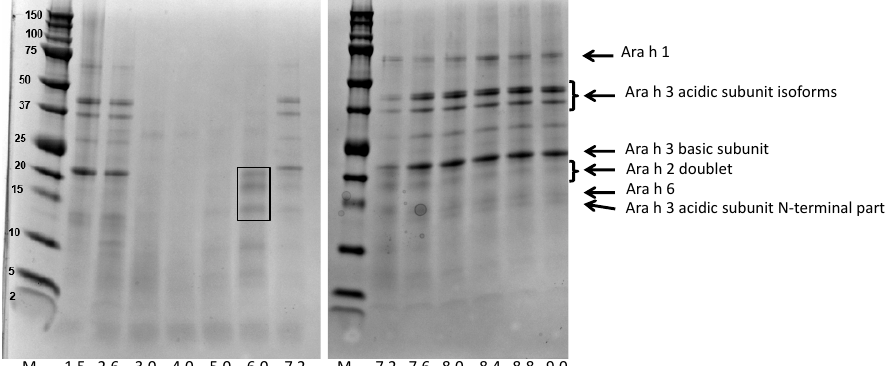
Figure 2. Protein profiles of extracts of light roasted peanut flour prepared at various pHs. Extraction was conducted for 90 min. Protein profiles determined by sodium dodecyl sulphate-polyacrylamide gel electrophoresis (SDS-PAGE), under reducing conditions, on 10–20% gradient gels). The line at the bottom shows the extraction pHs (M refers to the marker proteins, indicated in the left margin in kDa). The arrows at the right point to major allergens. The rectangle in the lane corresponding to pH = 6.0 indicates the Ara h2 doublet (top) and Ara h6 band (bottom).